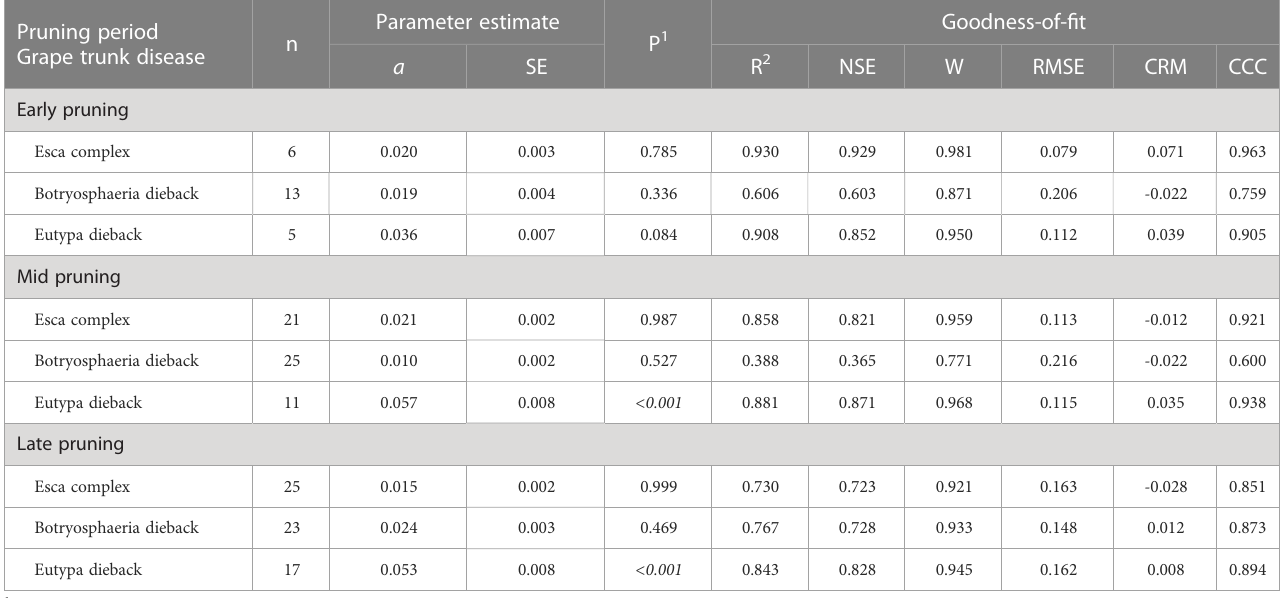
TABLE 3 Parameters and statistics of goodness-of- fi t for equation [1] (see text), which predicts pruning wound susceptibility as a function of time after pruning when wounds were inoculated for subsets of the data in Table 1 that concern the interaction between pruning period and grape trunk disease. Pruning period Grape trunk disease